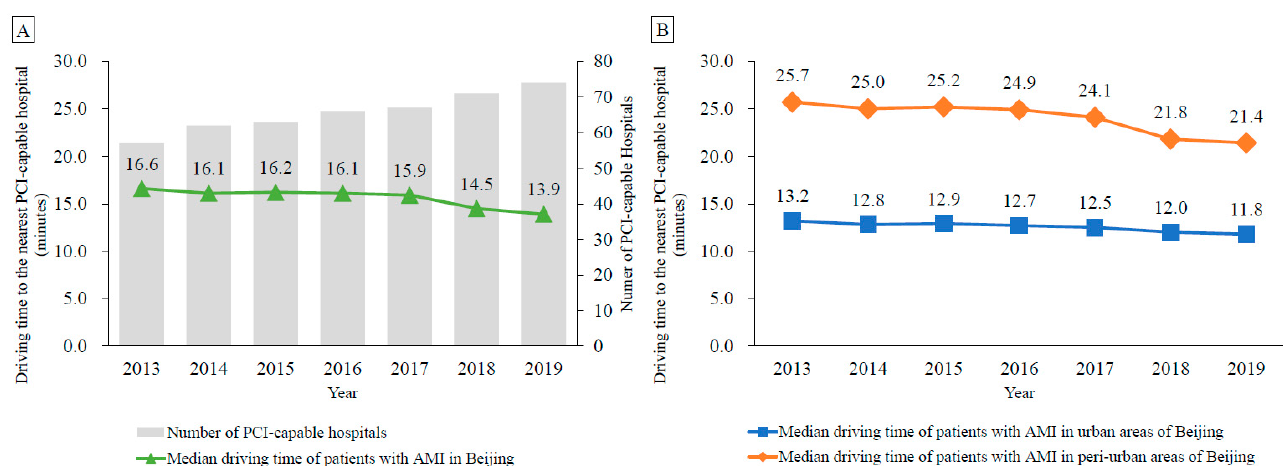
Figure 1. Median driving time to the nearest percutaneous coronary intervention-capable hospital in Beijing among patients with acute myocardial infarction, 2013–2019. ( A ) Median driving time of all patients in Beijing; ( B ) Median driving time of patients in urban and peri-urban areas of Beijing. Abbreviations: AMI, acute myocardial infarction; PCI, percutaneous coronary intervention.